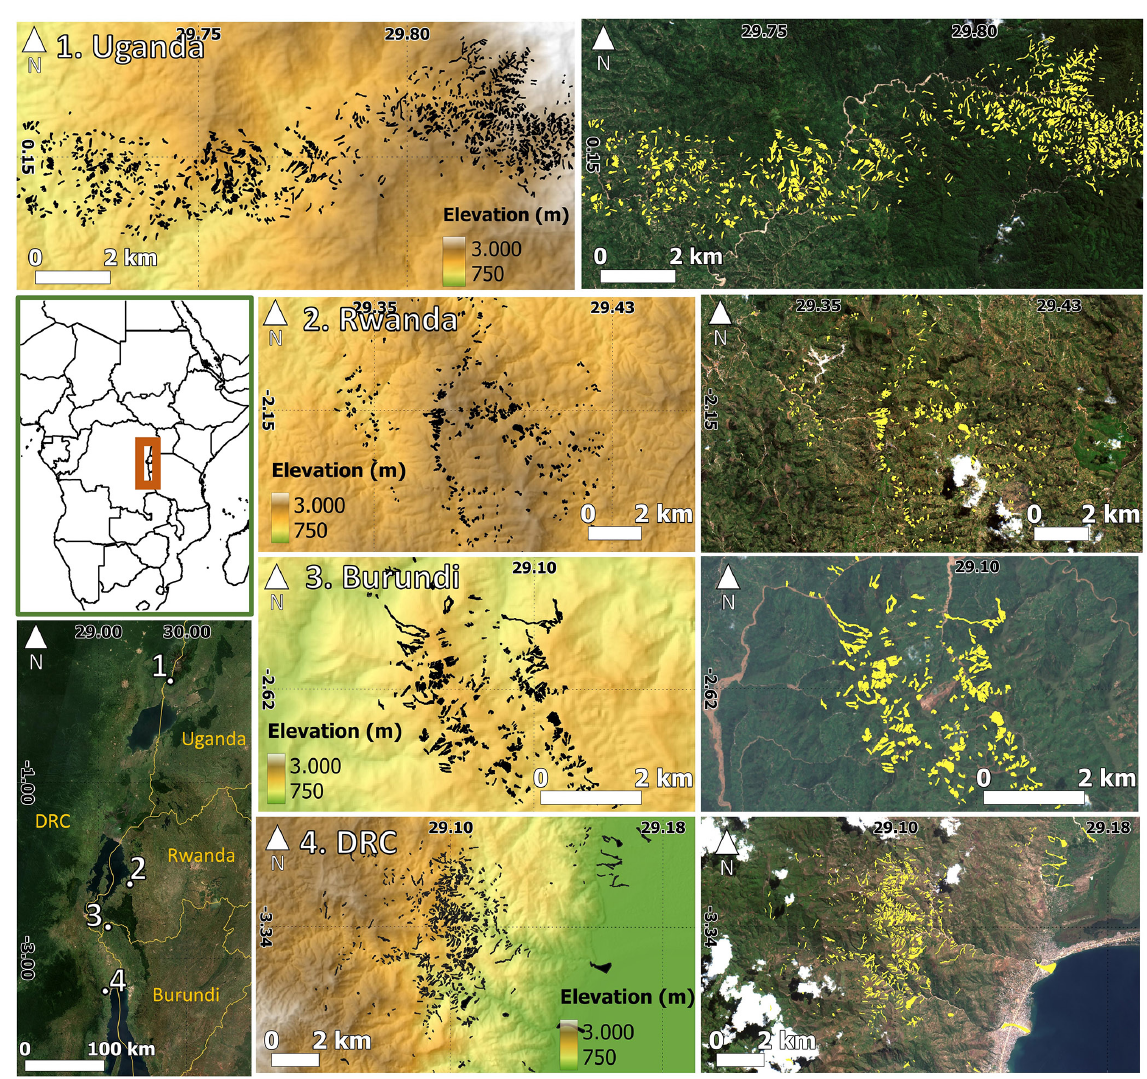
Figure 1. The location of the four GH events with their topographic (left: 30m ALOS 3D digital elevation model (DEM), GH event features in black) and optical (right: S2 post-event image, GH event features in yellow) context. Note that in the close vicinity of the GH events of Uganda and Burundi, large sediment-loaded riverbeds are visible. This is a consequence of the GH events that contributed directly to the transport of extra material to the rivers, increasing not only their sediment content but also their lateral mobility. These river dynamics are not included in our analysis. The two panels at the lower left depict the location of the GH sites (S2 imagery). Image credit: contains modified Copernicus Sentinel data (2022), processed with Google Earth Engine. ALOS 3D DEM data provided by Japan Aerospace Exploration Agency (JAXA). Table 1. Image information of manual mapping and dating GH events. Planet images are of the type PlanetScope Ortho Scene